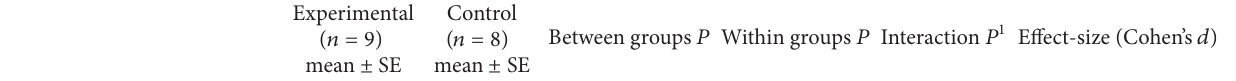
Table 2: Results at after intervention in the CT and control groups and